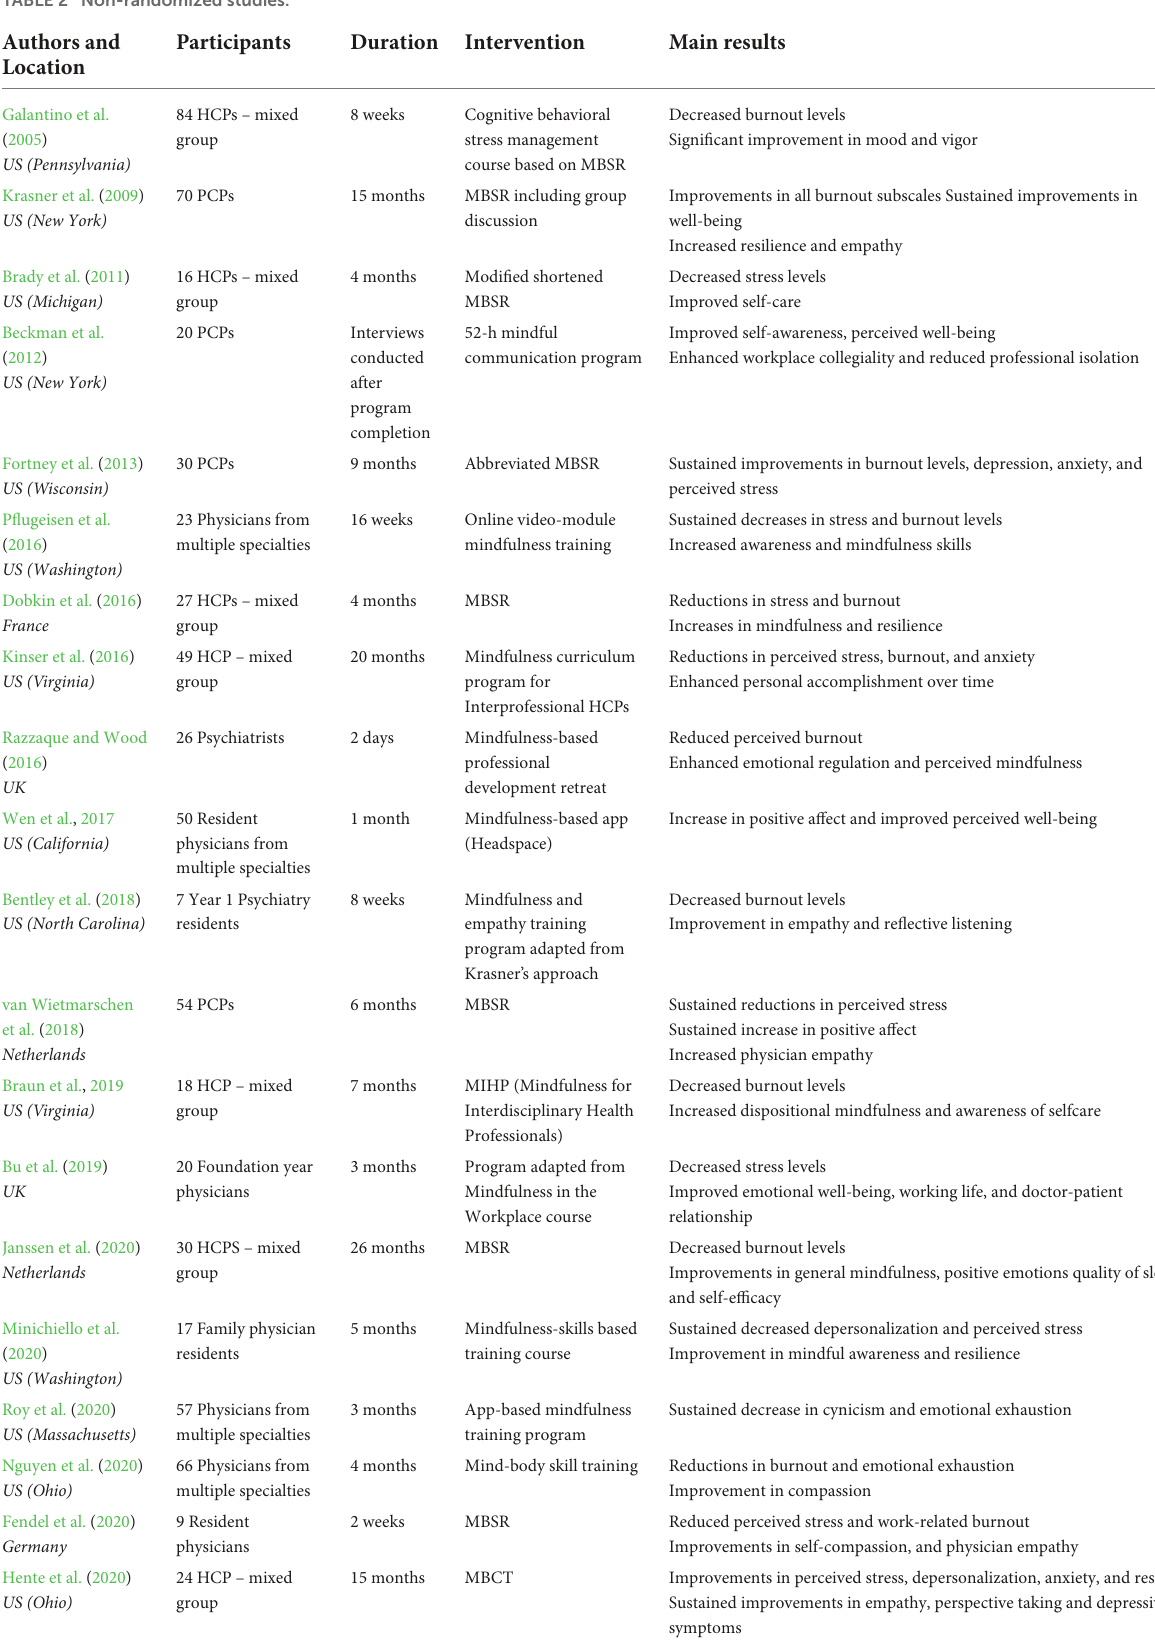
TABLE 2 Non-randomized